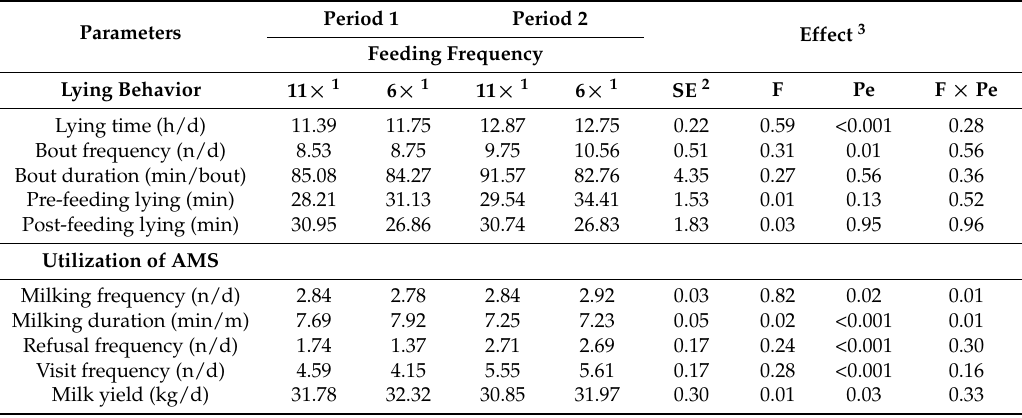
Table 1. Effect of feeding frequency, period, and interaction between feeding frequency and period on lying behavior, utilization of the automated milking system (AMS), and milk yield (least-squares